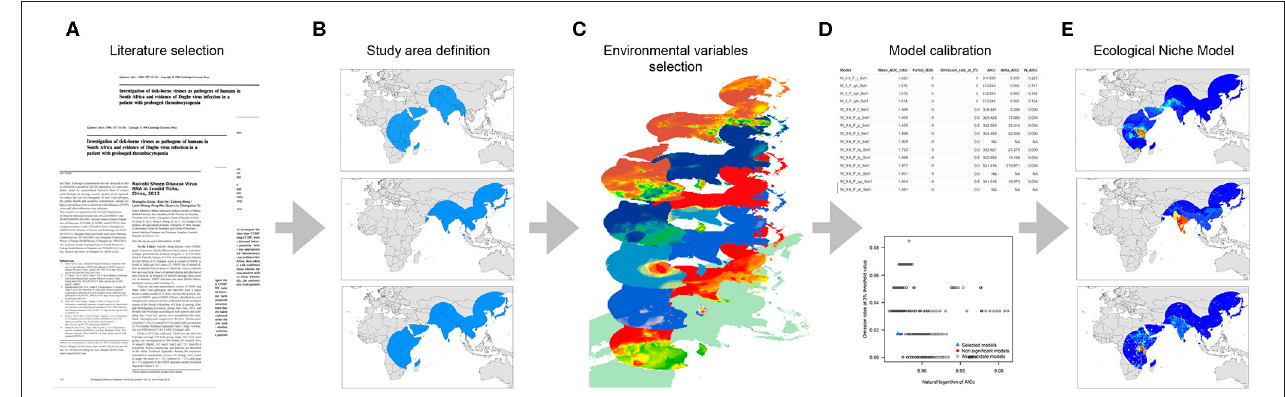
FIGURE 1 | Workflow of the modeling process. (A) Data collection based on literature review, (B) Study area definition, (C) Environmental variables selection, (D) Model calibration, and (E) Final ecological niche model.